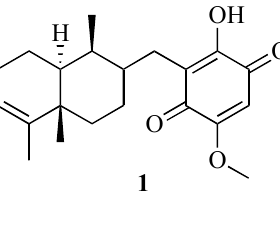
Figure 1. Chemical structure of the marine metabolite bolinaquinone ( 1